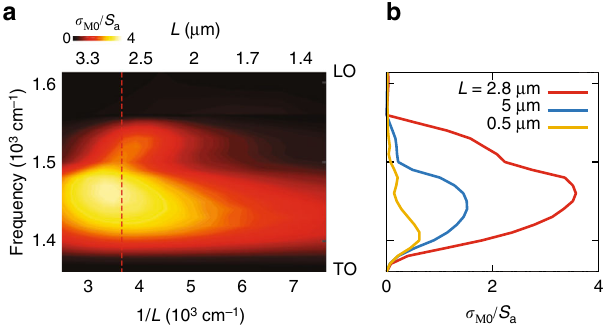
Fig. 6 Launching ef fi ciency of HPhPs for different gold antenna lengths. a Launching cross-section, σ M0 , normalized to the area of the antenna, S a as a function of both 1/ L and frequency. The vertical dotted line mark the 1/ L at which the red line shown in b has been extracted. b σ M0 / S a for the antennas with the lengths L = 2.8 μ m (red line), L = 5 μ m and L = 0.5 μ m. The vertical axes limits are the TO (bottom) and LO (top) phonon isopropanol 1:3. Afterwards, 3nm of a Ti stick layer was deposited by electron- beam evaporation onto the sample, followed by thermal evaporation of 40 nm of Au. Finally, the antennas were de fi ned by lift-off in acetone overnight. FTIR measurements of single antenna . Micro-spectroscopy transmission spectra were recorded with Bruker Hyperion 2000 IR microscope coupled to a Bruker